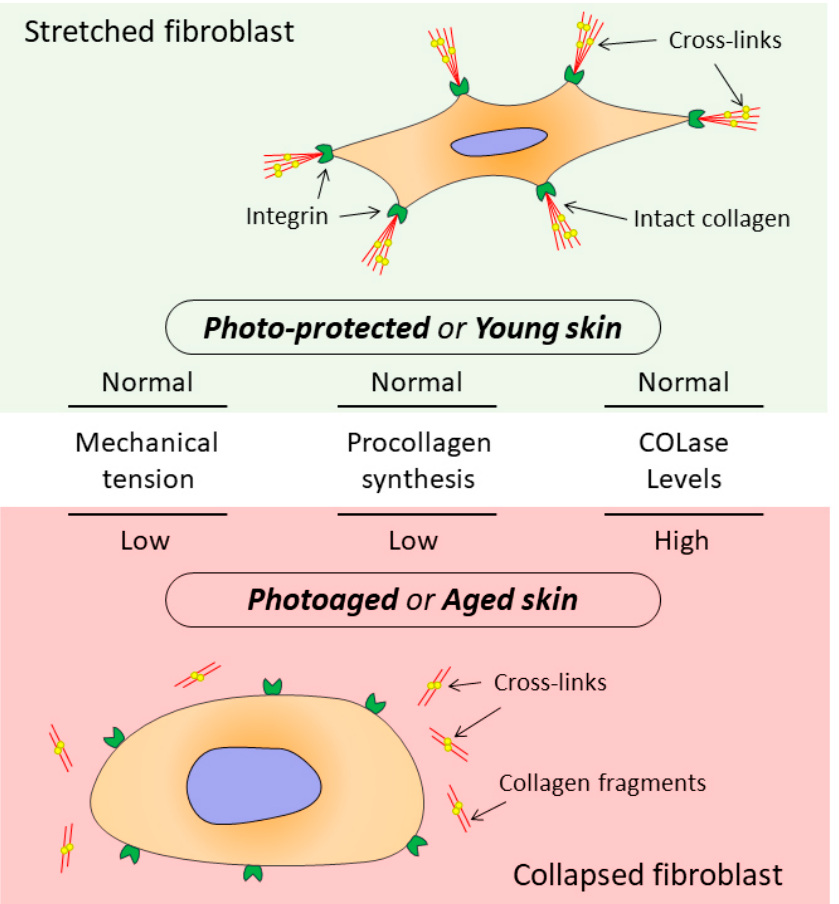
Figure 2. Schematic representation of the relationship between mechanical tension of CM and the DF cytoskeleton during collagen production in the human dermis. It has been revealed that integrins (heterodimeric transmembrane proteins, specific receptors, primarily, α 1 β 1 and α 2 β 1 to collagen type I [85]) located on the cell surface are able to specifically bind ECM proteins, in particular type I collagen [53]. The adhesion of integrins to ECM proteins contributes to the formation of bonds not only between integ- rins and the collagen matrix but also with actin (protein of the DF cytoskeleton) since integrins are attached to the CM from the outer surface of the cell membrane and con- nected to the cytoskeleton from the inner surface of the cell membrane, thereby creating focal adhesion complexes (focal contacts) that ensure the closely related regulatory and mechanical functions of DFs [11,53,86]. The formation of these complexes induces a cas- cade of intracellular signaling pathways that regulate the DF metabolism including the balance between production of collagens and their degradation by MMPs. Due to the